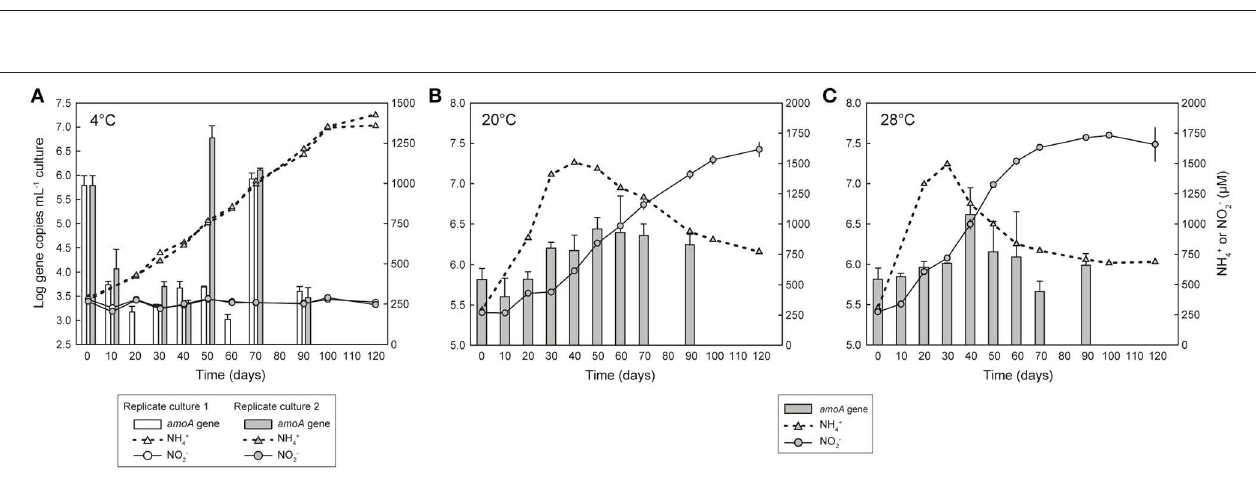
Frontiers in Microbiology |